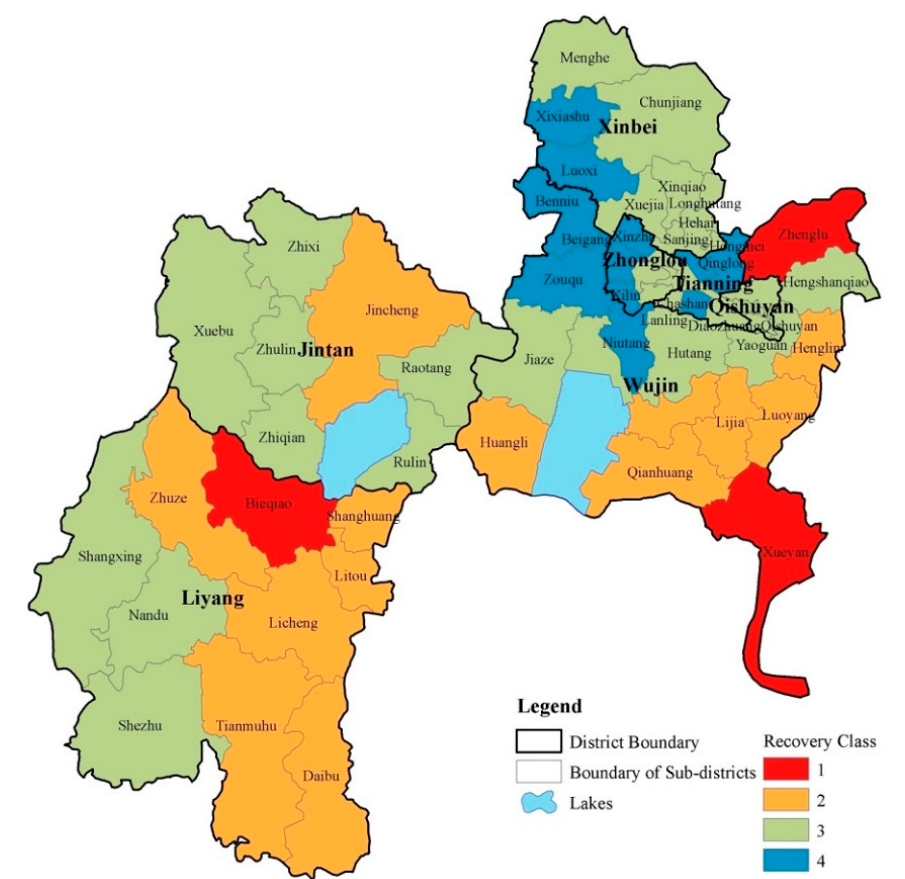
Figure 8. Recovery Class of each sub-district (or town): Class 4—high recovery capability; Class 3—moderate to high recovery capability; Class 2—moderate to low recovery capability; Class 1—low recovery capability.